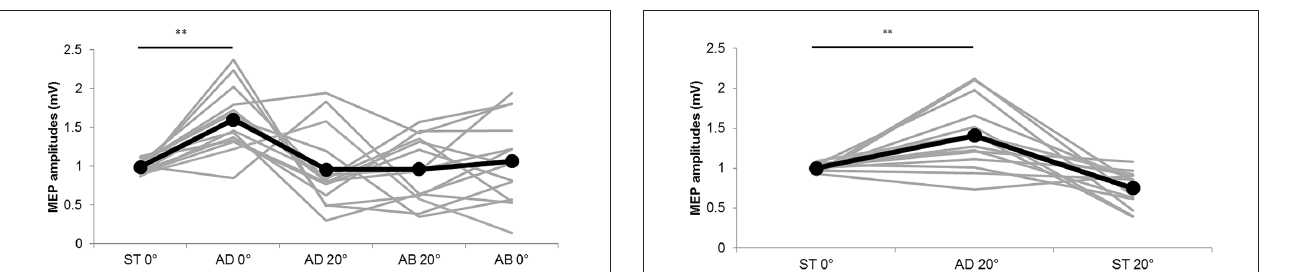
FIGURE 5 | MEP amplitudes during static and passive movement conditions in Experiment 2. The black line shows the mean MEP amplitude and the gray lines the individual values in Experiment 2 at 0 ◦ static joint angle (ST 0 ◦ ), 20 ◦ adduction during passive adduction (AD 20 ◦ ) and static 20 ◦ adduction angle (ST 20 ◦ ). MEP amplitude was significantly increased at AD 20 ◦ compared with ST 0 ◦ ( ∗∗ p < 0.01). (20 ◦ adduction during abduction movement) in Experiment 1.